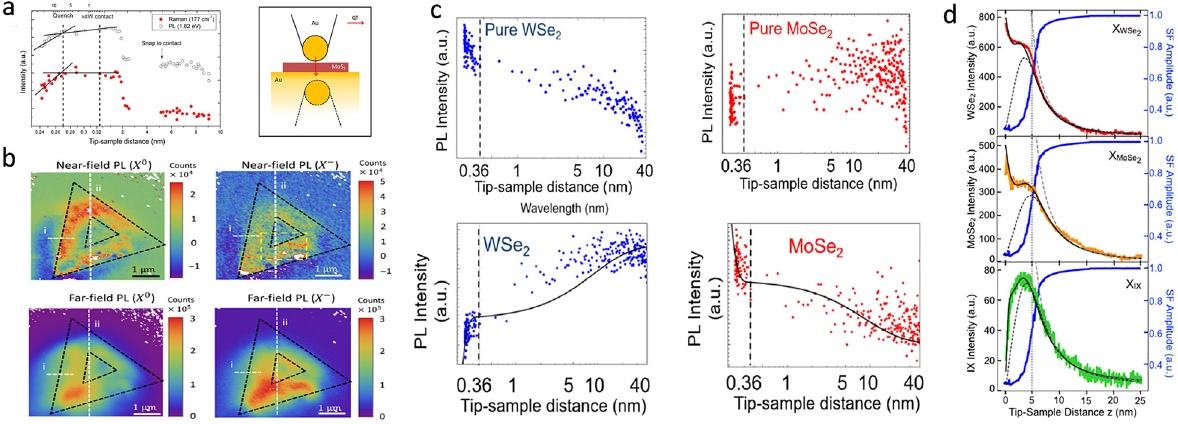
Figure 12: Plasmon resonance effect by metallic tip. (a) Few-layer MoS 2 PL and Raman intensity depending on tip-sample distance (left) and the illustration of tip-induced plasmon resonance (right). Reproduced with permission from ref. [141]. Copyright 2016, Nature Publishing Group. (b) Upper panel: TEPL images of 1L-WS 2 of exciton (left) and trion (right). Lower panel: exciton (left) and trion (right) images obtained by far- fi eld imaging. Reproduced with permission fromref.[142].Copyright2019,AmericanAssociationfortheAdvancementofScience.(c)Upperpanel:TEPLintensityofWSe 2 (left)andMoSe 2 (right) depending on tip-sample distance. Lower panel: TEPL intensity of lateral WSe 2 /MoSe 2 HJ in depletion region of WSe 2 (left) and MoSe 2 (right) depending on tip-sample distance. Reproduced with permission from ref. [96]. Copyright 2018, American Physical Society. (d) Fitted TEPLintensitypro fi lesWSe 2 (red),MoSe 2 (gold),andinterlayerexcitonpeaks(green)versustip-sampledistanceobtainedfromverticalWSe 2 / MoSe 2 . Blue lines display the shear-force feedback amplitude. Reproduced with permission from ref. [89]. Copyright 2021, Nature Publishing